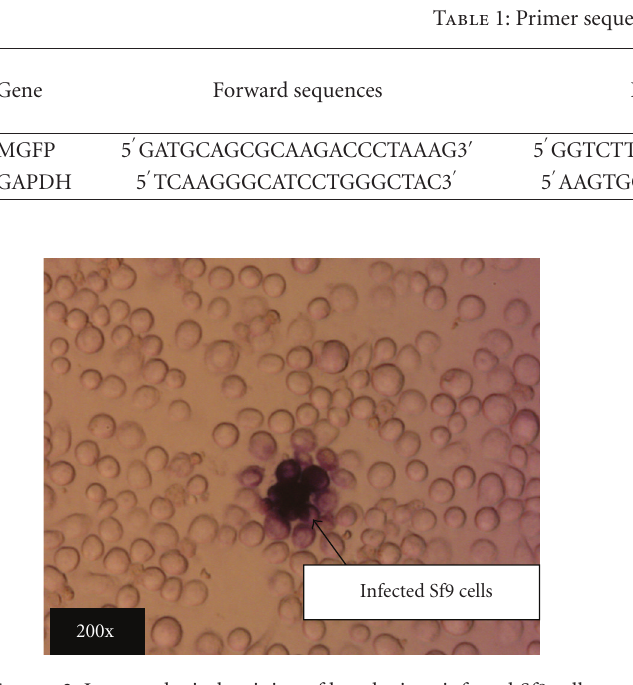
Figure 2: Immunological staining of baculovirus-infected Sf9 cells using FastPlax Titre kit. The Sf9 cells were infected with diluted baculoviral stock, and after 24hrs the cells were fixed, and gp64 protein was detected on the cell surfaces by using monoclonal anti- gp64 antibody and β -galactosidase-conjugated secondary